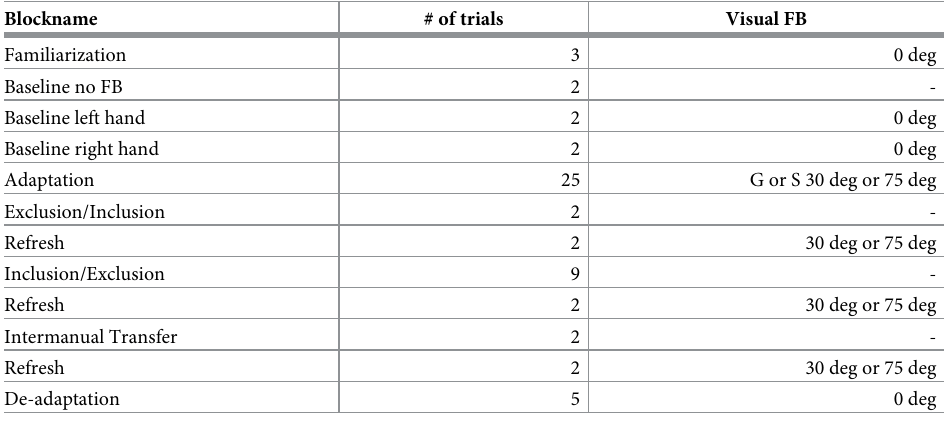
Table 1. Experimental protocol. Blockname # of trials Visual FB Familiarization 3 0 deg Baseline no FB 2 - Baseline left hand 2 0 deg Baseline right hand 2 0 deg Adaptation 25 G or S 30 deg or 75 deg Exclusion/Inclusion 2 - Refresh 2 30 deg or 75 deg Inclusion/Exclusion 9 - Refresh 2 30 deg or 75 deg Intermanual Transfer 2 - Refresh 2 30 deg or 75 deg De-adaptation 5 0